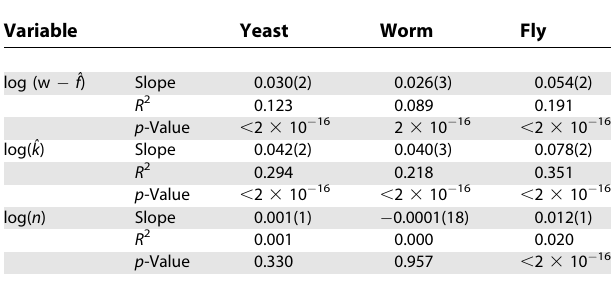
Table 7. The False-Discovery Rate for a Bait Protein, ˆf / n , Positively Correlated with the Estimated Number of True Interaction Partners That Are Observed, w (cid:2) ˆf , and the Total Number,